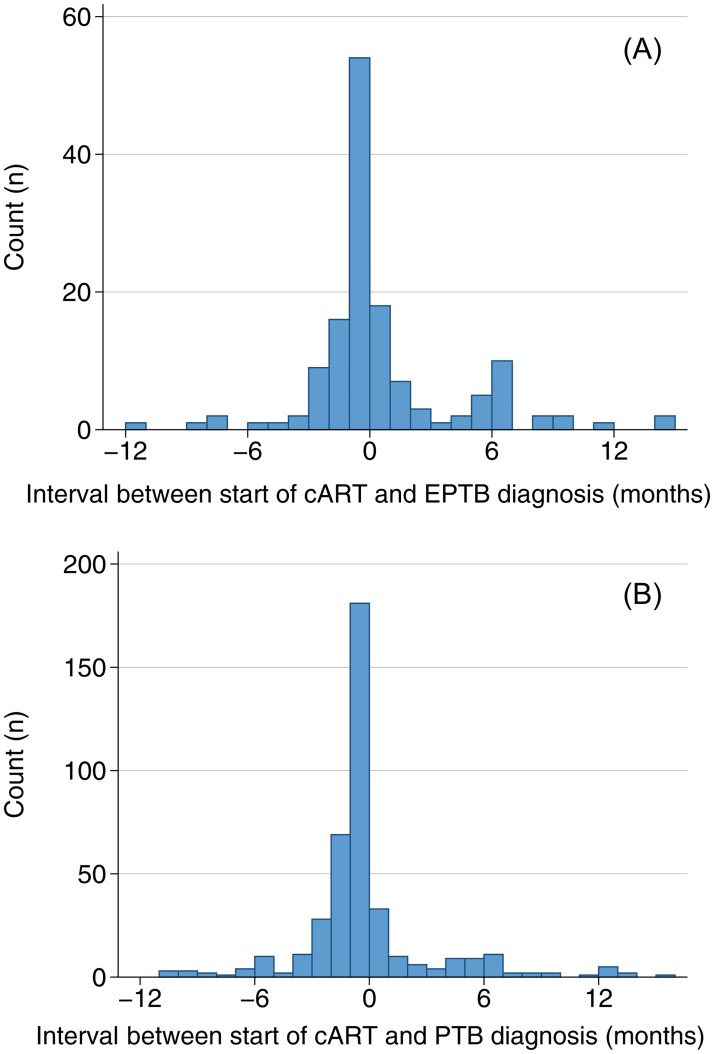
Interval between start of antiretroviral treatment and diagnosis of tuberculosis.(A) extrapulmonary tuberculosis (EPTB), (B) pulmonary tuberculosis (PTB). Time point “0” denotes the initiation of cART, negative values indicate that the diagnosis of TB was preceding the initiation of cART.